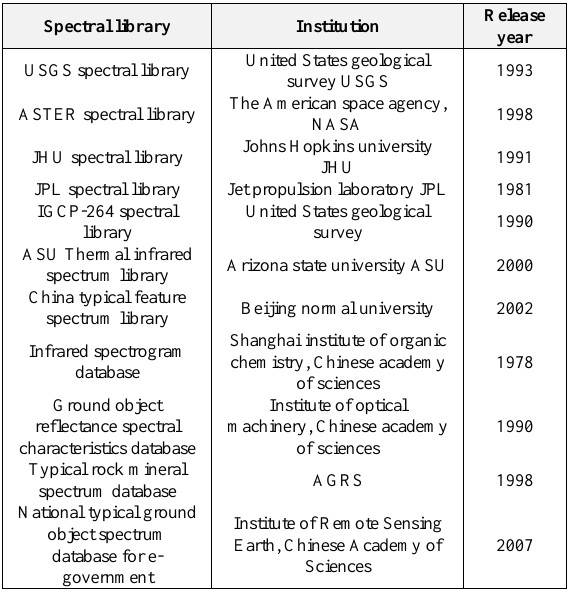
Table 1. Overview of current important spectral